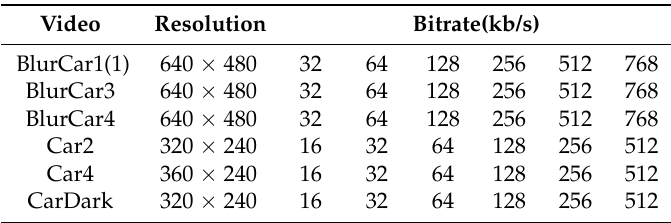
Table 1. The encoded bitrate of videos.